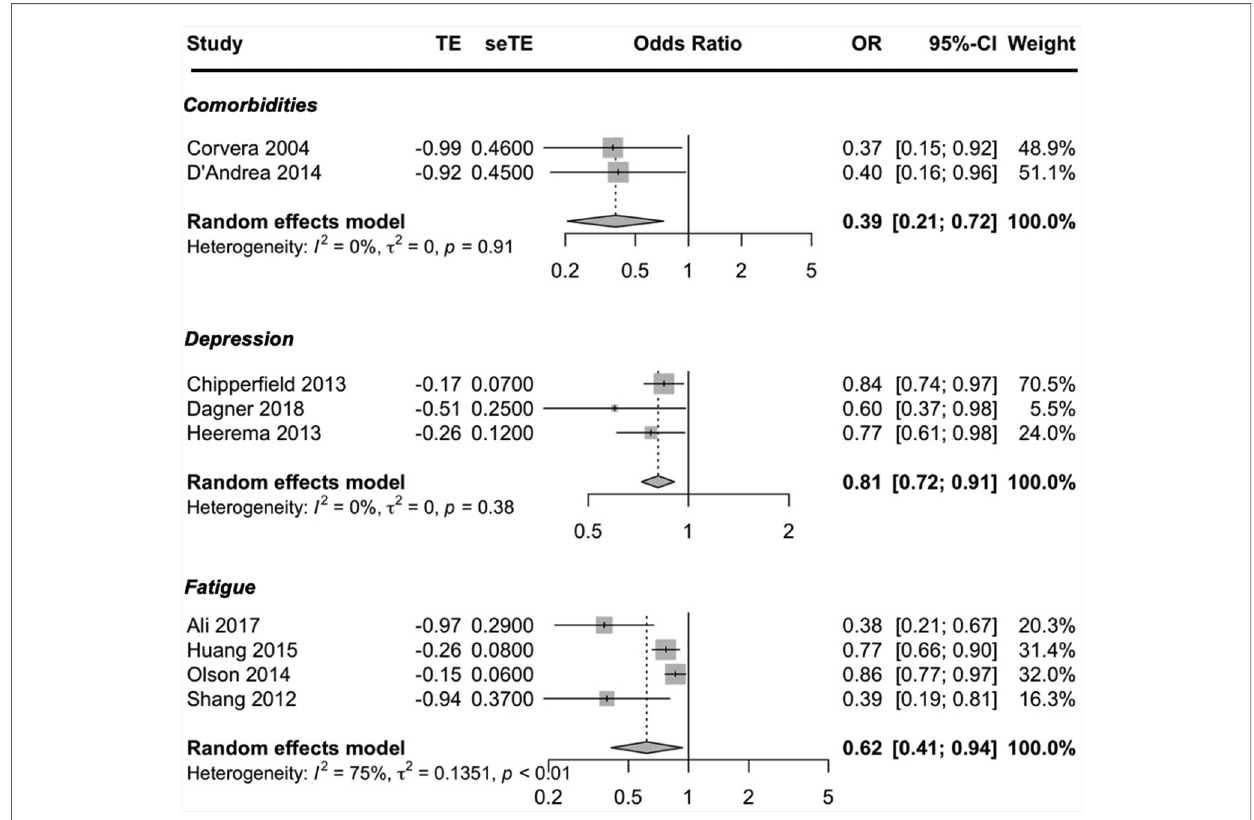
FIGURE 4 Forest plot condition-related